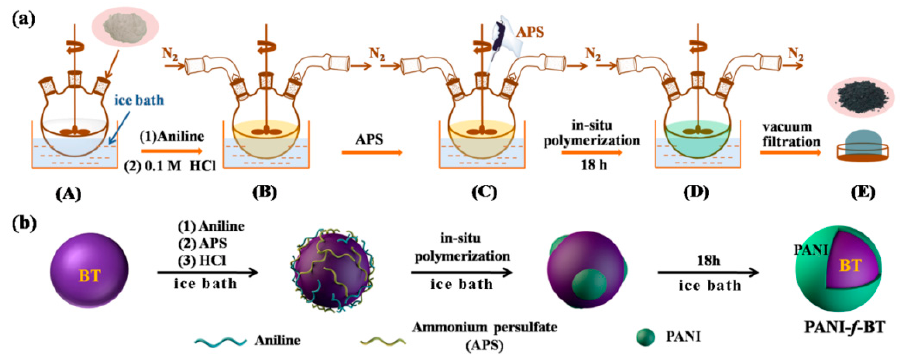
Figure 1. Experimental steps ( a ) and schematic diagram ( b ) of the polyaniline functionalized barium titanate (PANI- f -BT) nanoparticles..